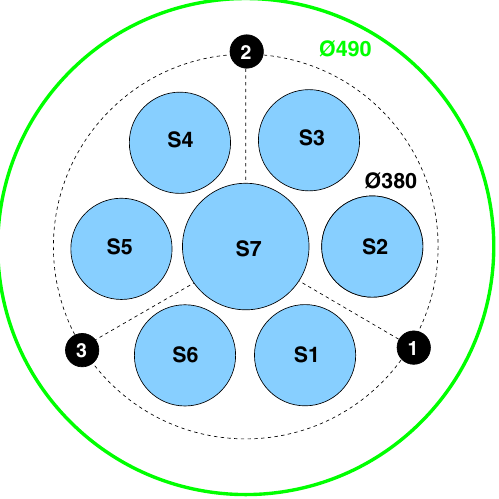
Fig. 32 View of the array from top. The positions of the three cali- bration sources (1, 2, 3) and the boundaries of the LAr veto system (Ø490mm) are indicated. The surrounding radon shroud with a diam- eter of 750mm [5] is not